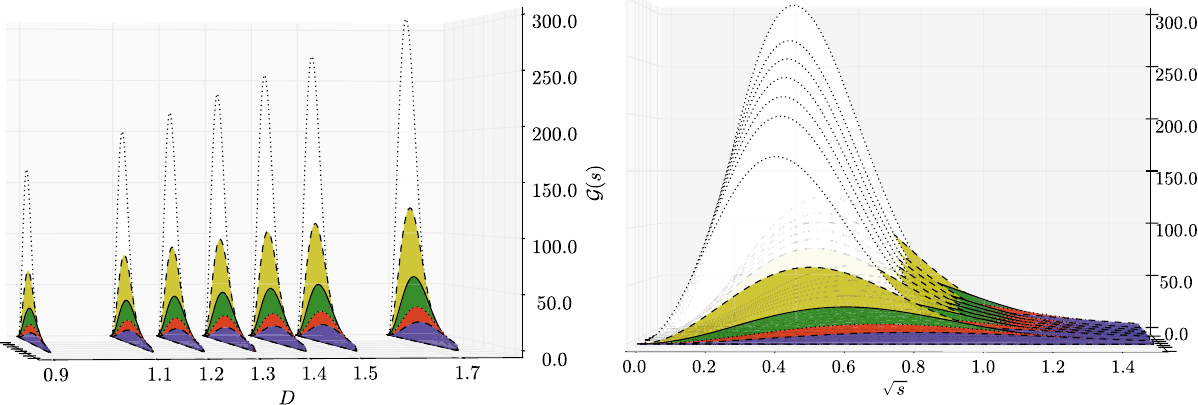
Fig. 1 The various forms of the effective coupling, Eq. (3), in condensed comparison (see